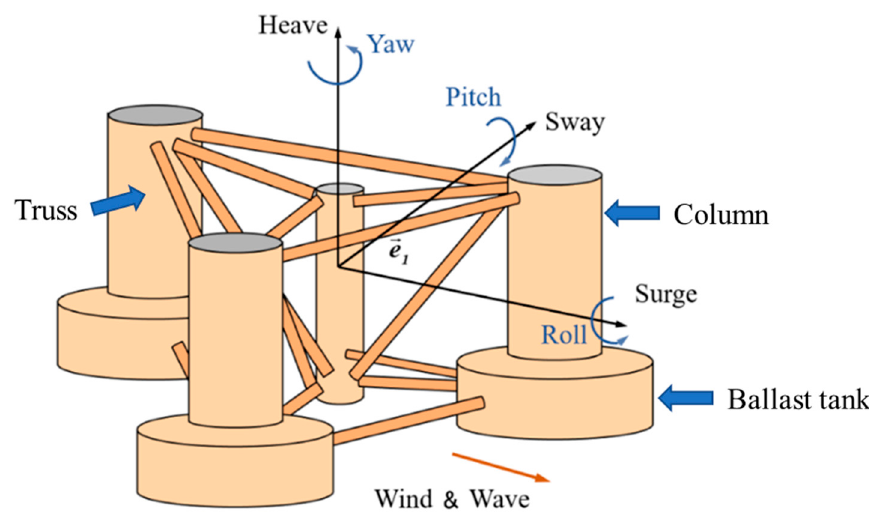
Figure 2. Definition of the DOFs of the floater.